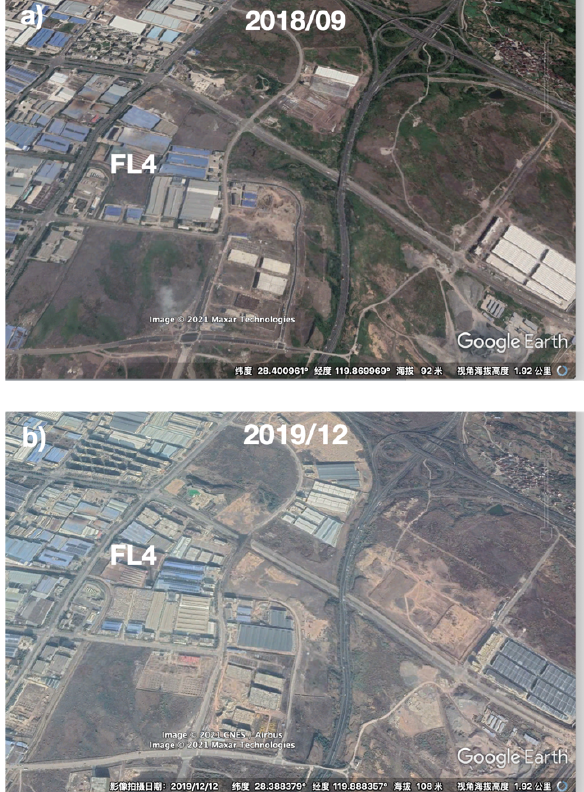
Figure 6 . Google Earth TM images of FL4 acquired at Sep. 2018 and Dec.